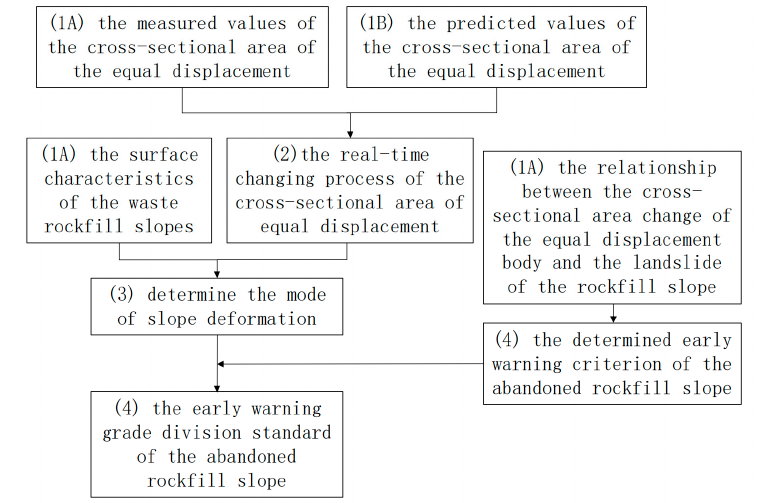
Figure 10. Early warning method of landslides.